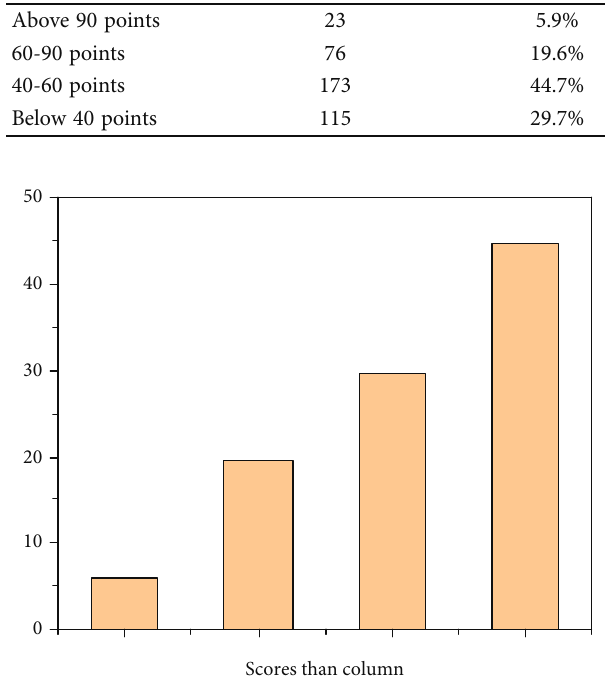
Figure 2: Pie chart of college entrance examination